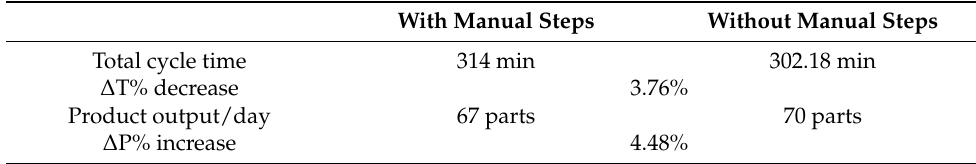
Table 8. Effect of removing first-off inspection. With Manual Steps Without Manual